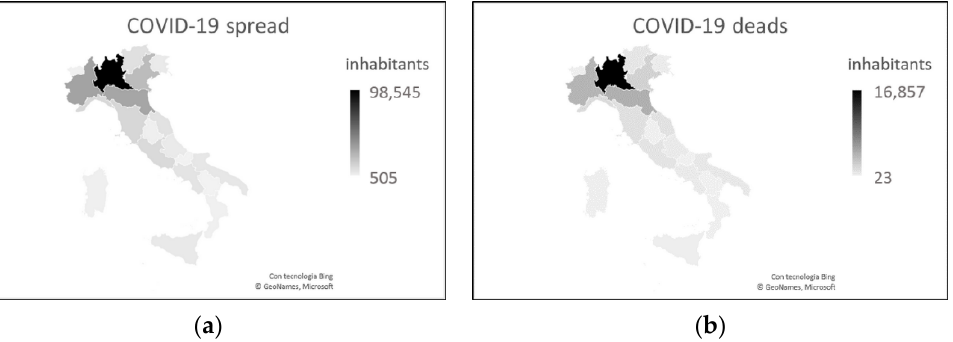
Figure 1. COVID-19 data as of 25 August 2020. ( a ) Number of cases. ( b ) Number of deaths. Both graphs show the greatest severity in northern Italy, particularly in the Lombardy region.